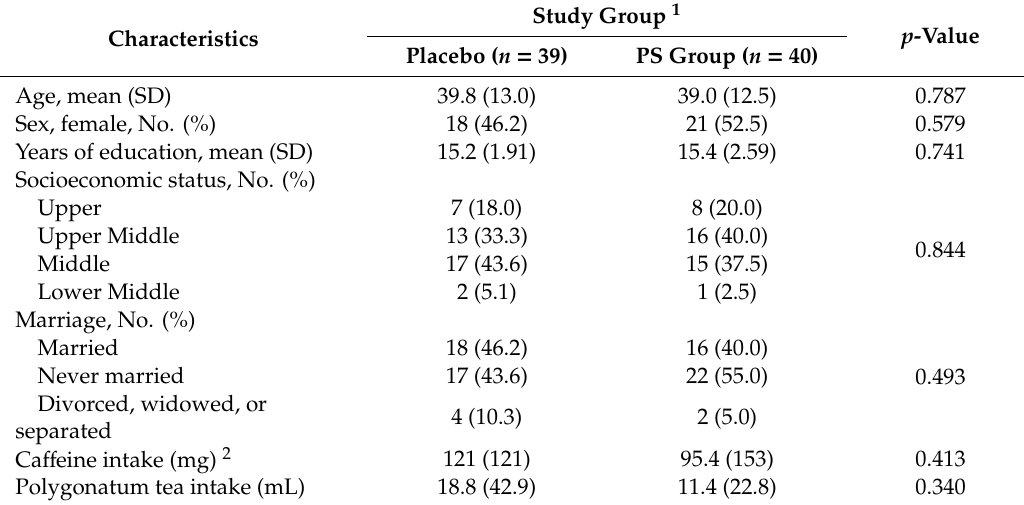
Table 1. Baseline demographic and clinical